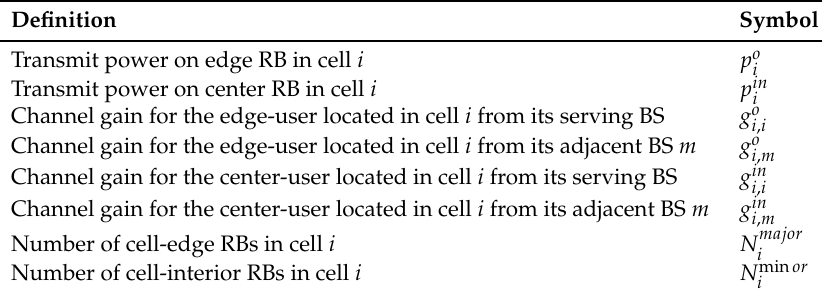
Table 1. Symbols